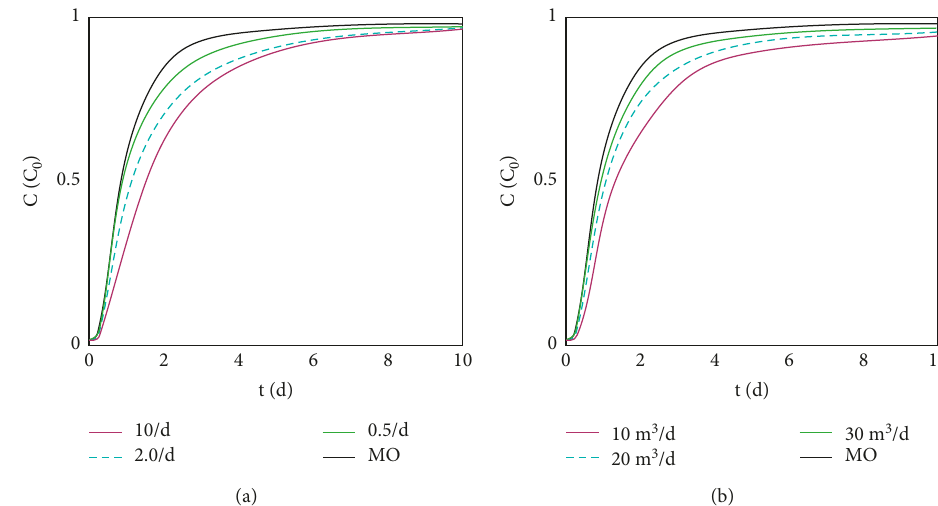
Figure 9: Effect of variable flow rate on pollutant transport.